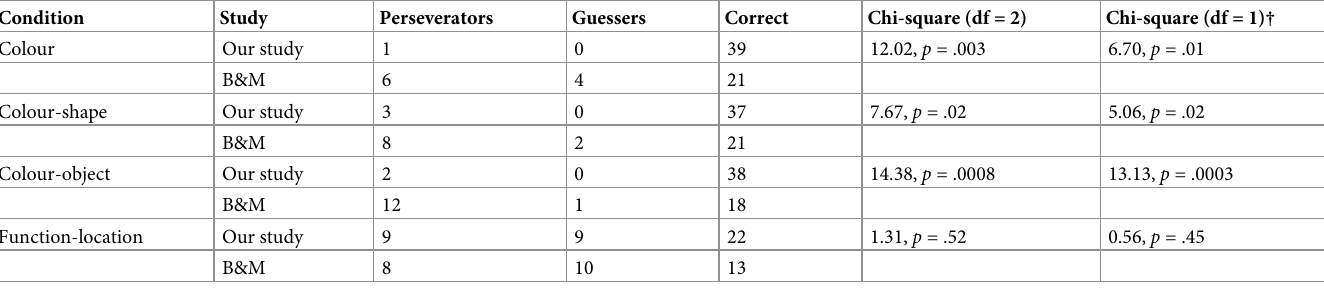
Table 2. Distribution comparison of the bilinguals in the present study and Bialystok and Martin’s (2004) study.